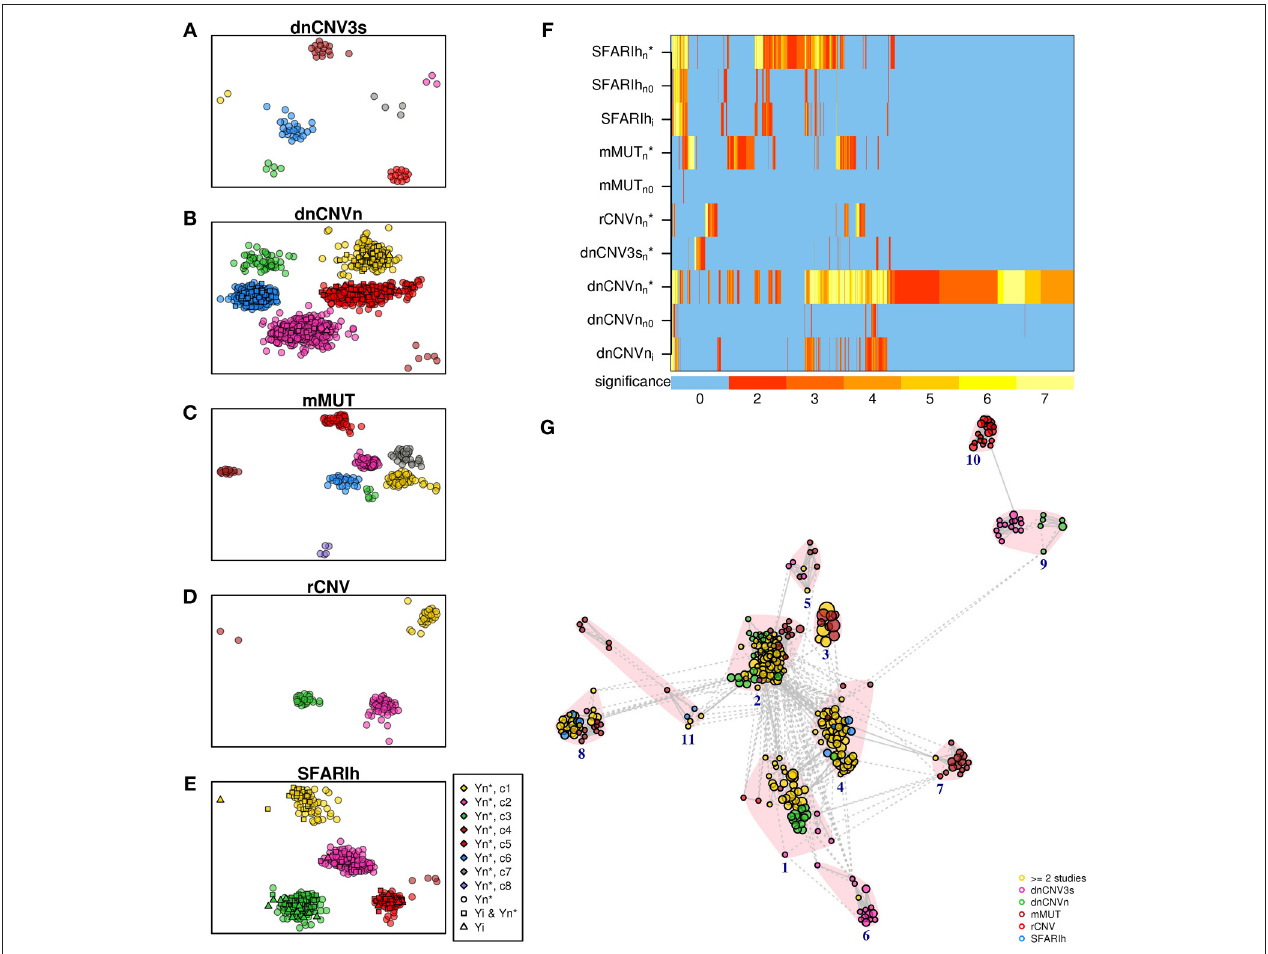
FIGURE 7 | Significant pathways enriched in genes associated with ASD. (A–E) Pathways found in the analysis of each original list ( i ) and corresponding predicted genes (n*). (F) Heatmap of all the pathways found in the analysis of the lists reported on the rows; also pathways found analyzing the original lists without genes not occurring in the STRING network ( n 0 ) are represented; the color bar indicates the − log 10 ( p ) of the hypergeomtric p -value, adjusted for multiple hypothesis testing; the number 7 indicates p ≤ 10 − 7 . (G) Enrichment map; vertex size is proportional to pathway significance (adjusted p -value); links are reported only for overlap coefficients > 0.5; for each pathway, only the links with the top 5 most similar pathways are drawn. (A–G) See Supplementary Table